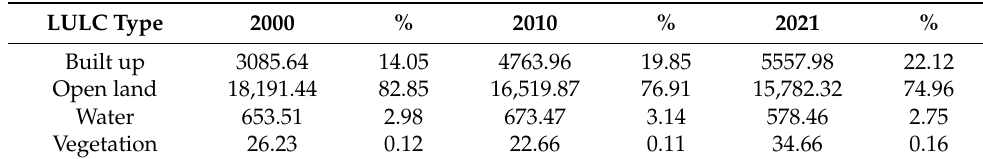
Table 2. LULC in Jeddah megacity for the indicated years.